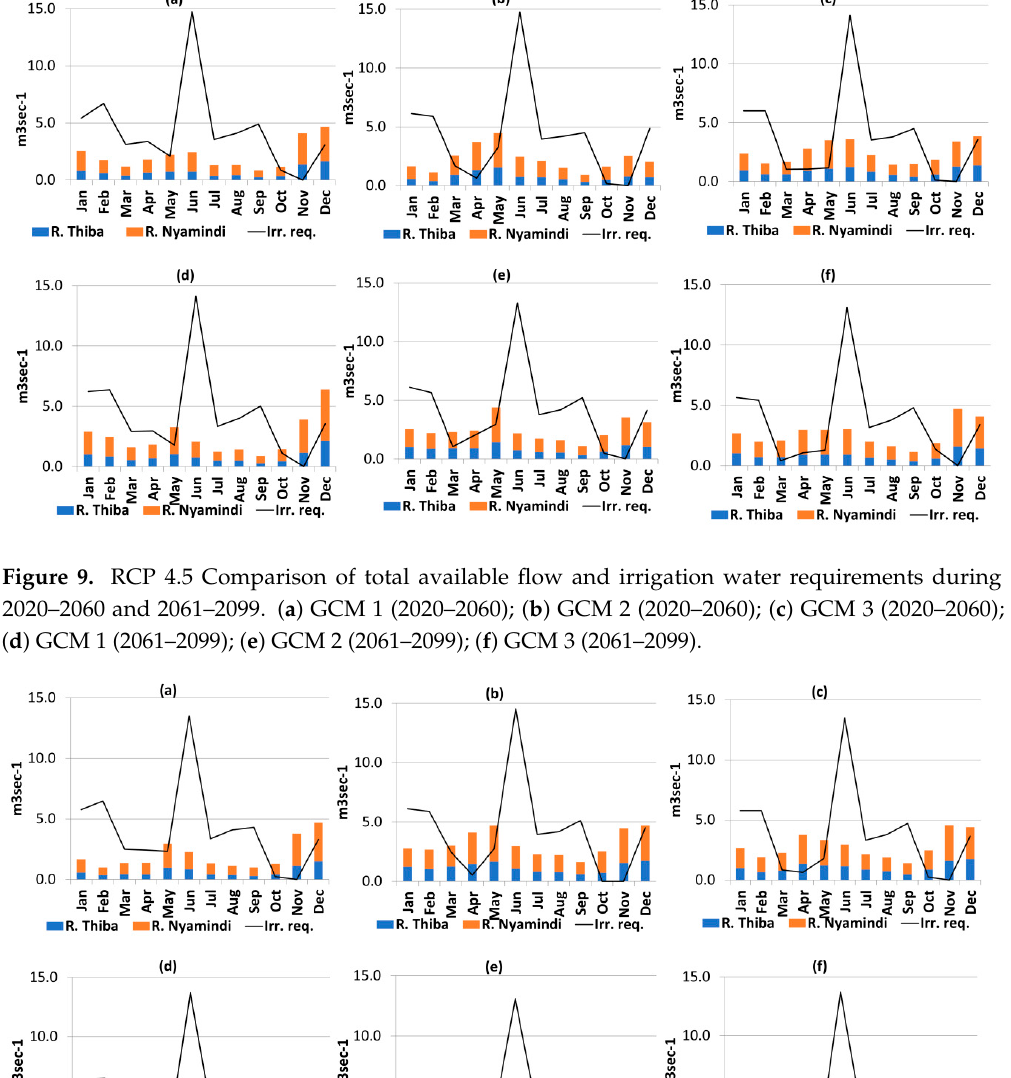
Figure 8. RCP 2.6 Comparison of total available flow and irrigation water requirements during